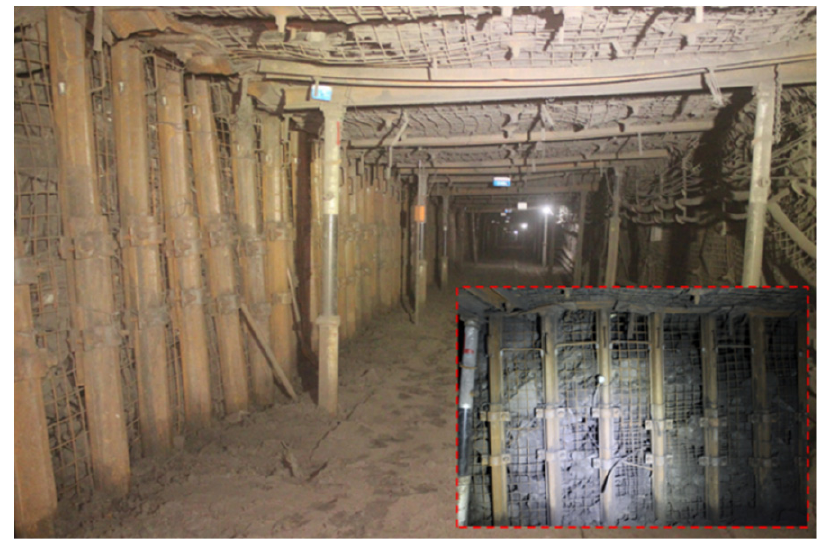
Figure 16. Field application effect.